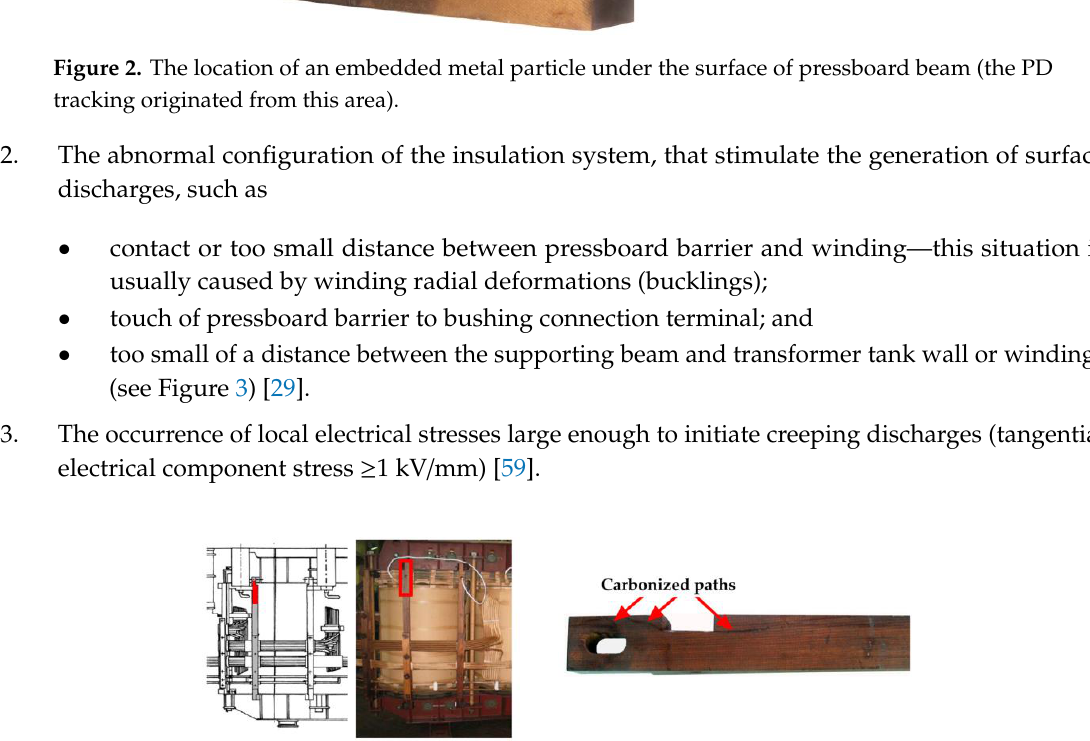
Figure 3. Example of surface discharge occurrence in a 16 MVA power transformer caused by too small of a distance between the supporting beam and the winding: ( a ) construction scheme and the picture of transformer active part with marked location of the defect and ( b ) picture of supporting beam with visible permanent carbonized paths.